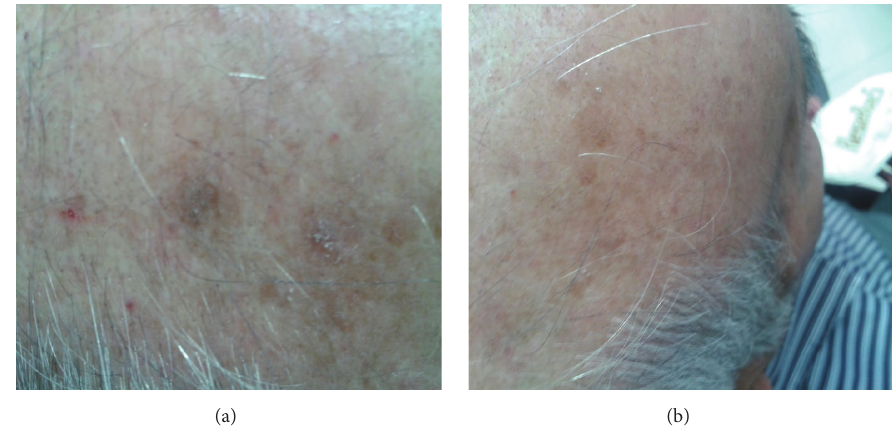
Figure 3: AKs on the scalp of a participant in the diclofenac group (a) at baseline and (b) at the end of the study (8 weeks of treatment).